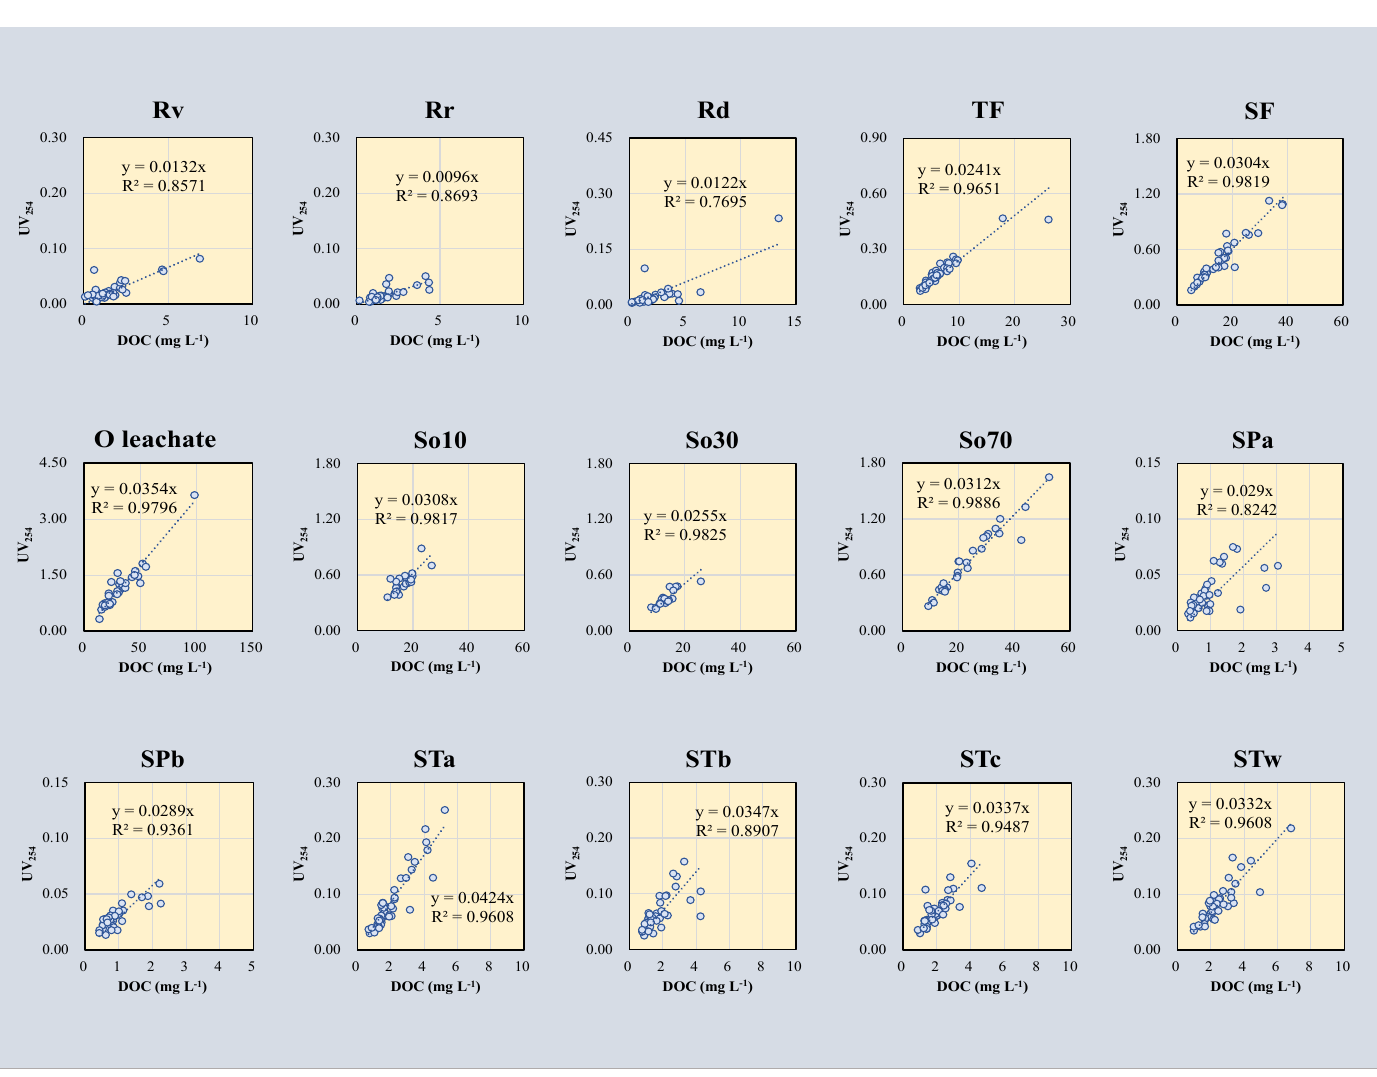
Figure 6. Relationships between DOC concentration and UV. 254 for all sample types. See Figure 1 for the meaning of the